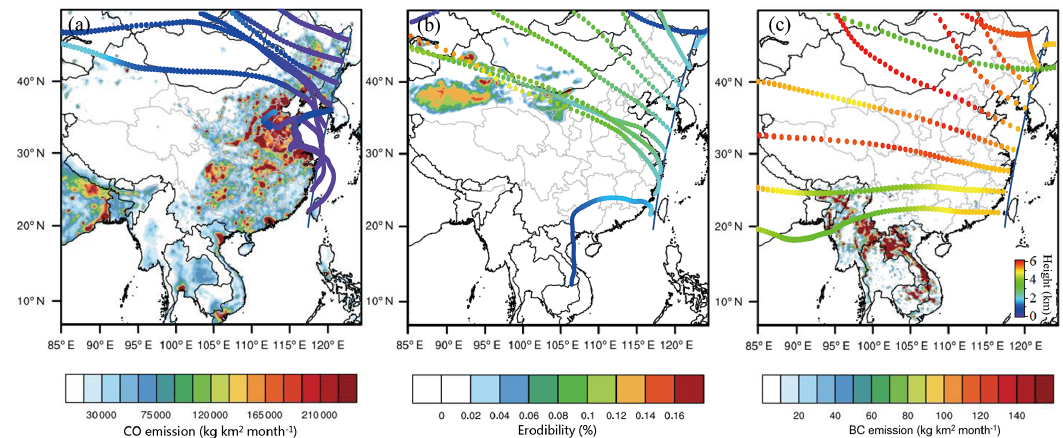
Figure 7. The 7-day backward trajectory at different altitudes of (a) 10m, (b) 2000m and (c) 5000m above ground level along the satellite orbit. Note that anthropogenic carbon monoxide emissions, soil erodibility and BC emissions from biomass burning are shown on these maps.